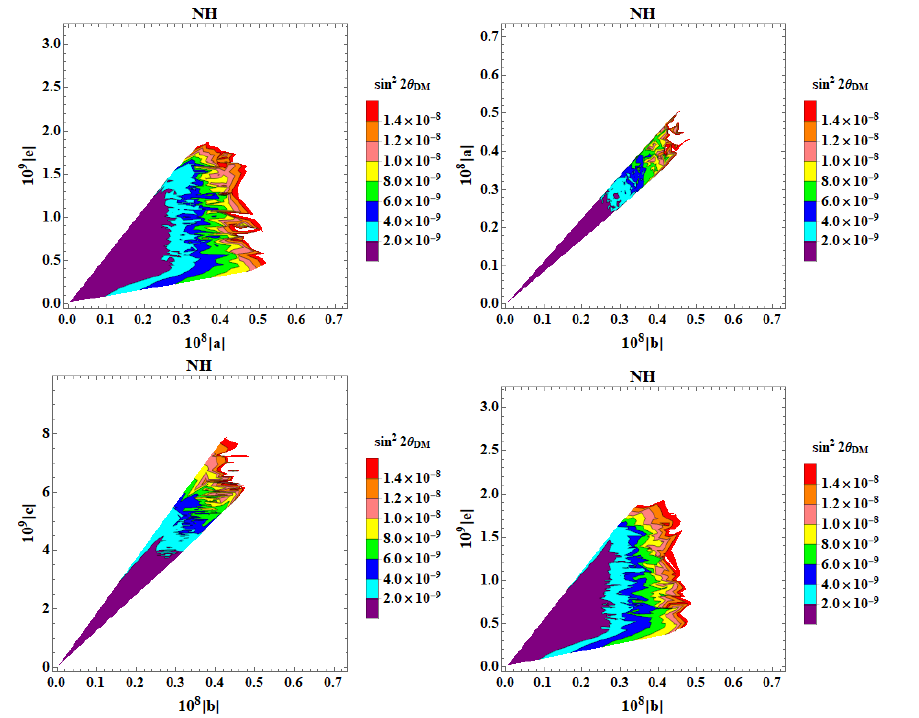
Figure 10 . Variation of di(cid:11)erent model parameters (in eV) with the DM-active mixing as the contour for normal hierarchy. The limit as predicted by cosmology is (10 (cid:0) 12 (cid:0) 10 (cid:0) 8